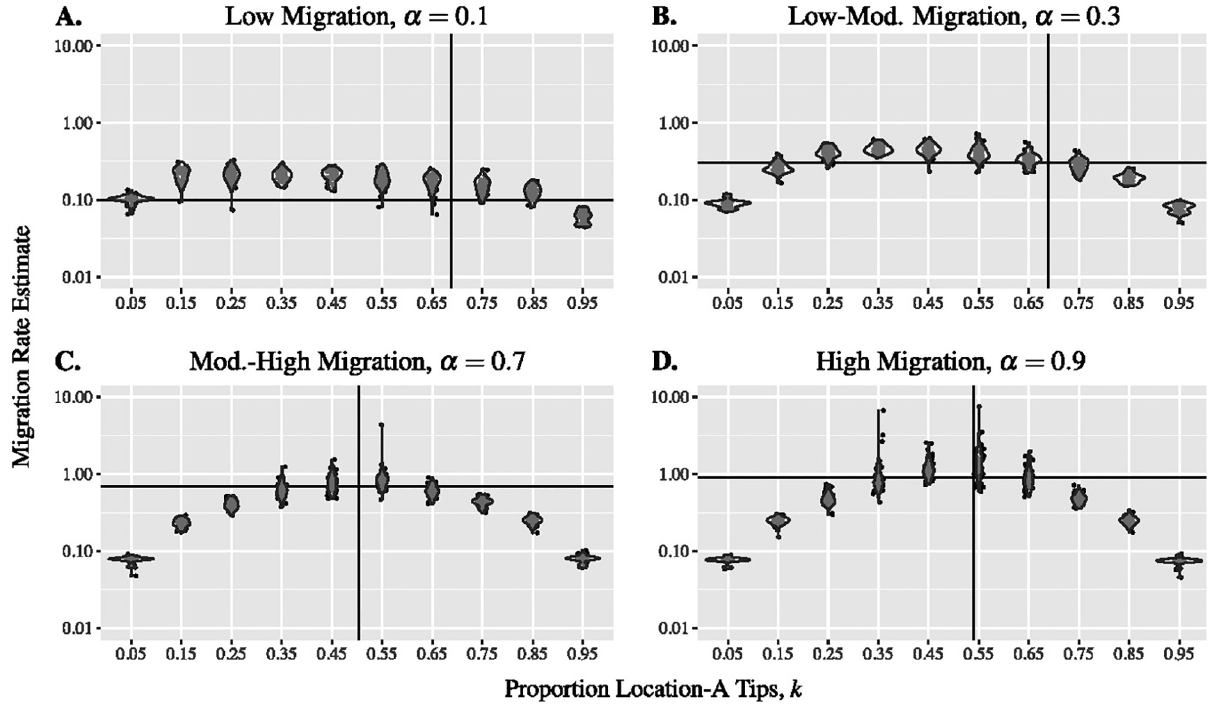
Fig 3. Sampling bias affects the migration rate estimate. Estimated migration rates from trees with varying migration rate. The true trees for each panel are shown in Fig 1A (Panel A), Fig 1C (Panel B),Fig 4A (Panel C), and Fig 1C (Panel D). Vertical lines indicate the true proportion of location-A tips and the horizontal lines indicate the true migrations rates. Parameters: λ = 4 and μ =